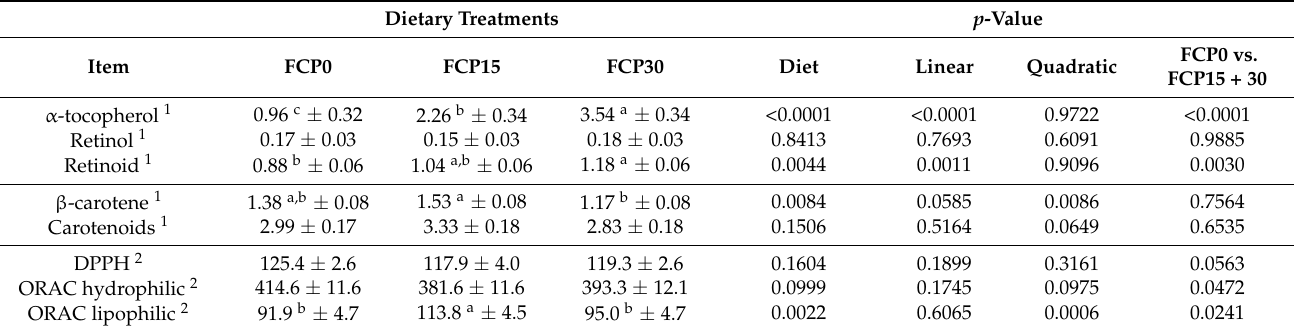
Table 4. Least square means ± standard errors of micronutrient content and meat antioxidant capacity according to dietary